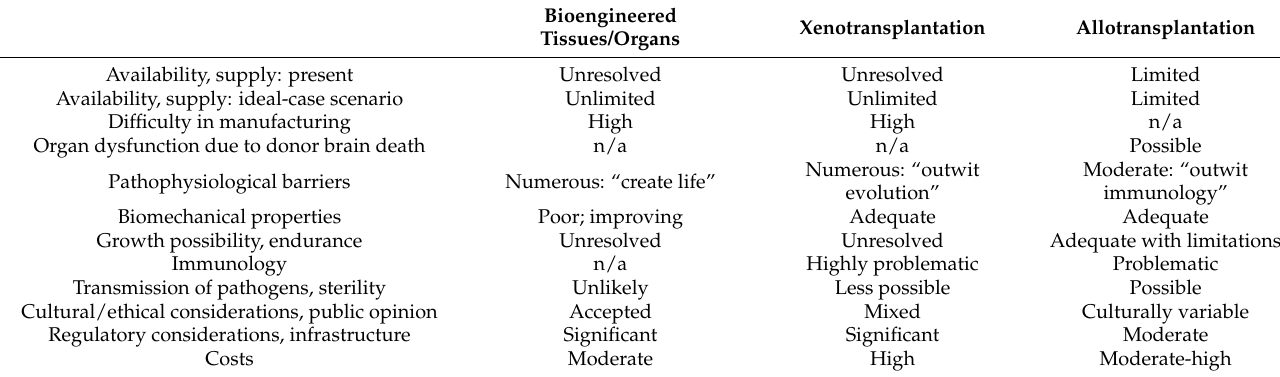
Table 3. Characteristics of bioengineered materials, xeno- and allotransplantation. Bioengineered